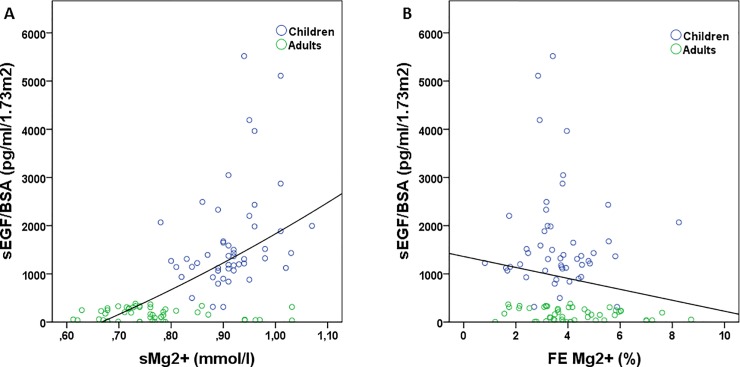
Correlation between serum EGF and serum magnesium (A; r = 0.597; p<0.001) and serum EGF and the FE Mg2+ (B; r = -0.200; p = 0.048). sEGF: serum epidermal growth factor; BSA: body surface area; sMg2+: serum magnesium; FE Mg2+: fractional excretion of magnesium.